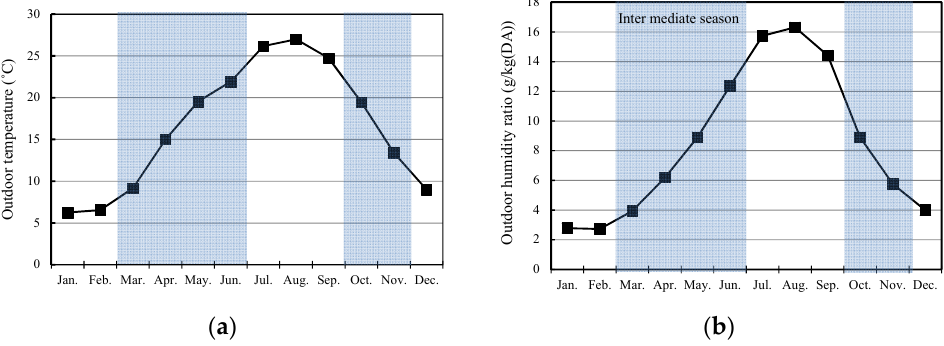
Figure 10. Average monthly outdoor air temperature and humidity ratio (obtained from the automated meteorological data acquisition system data (AMeDAS), Tokyo, Japan): ( a ) outdoor air temperature and ( b ) outdoor air humidity ratio.